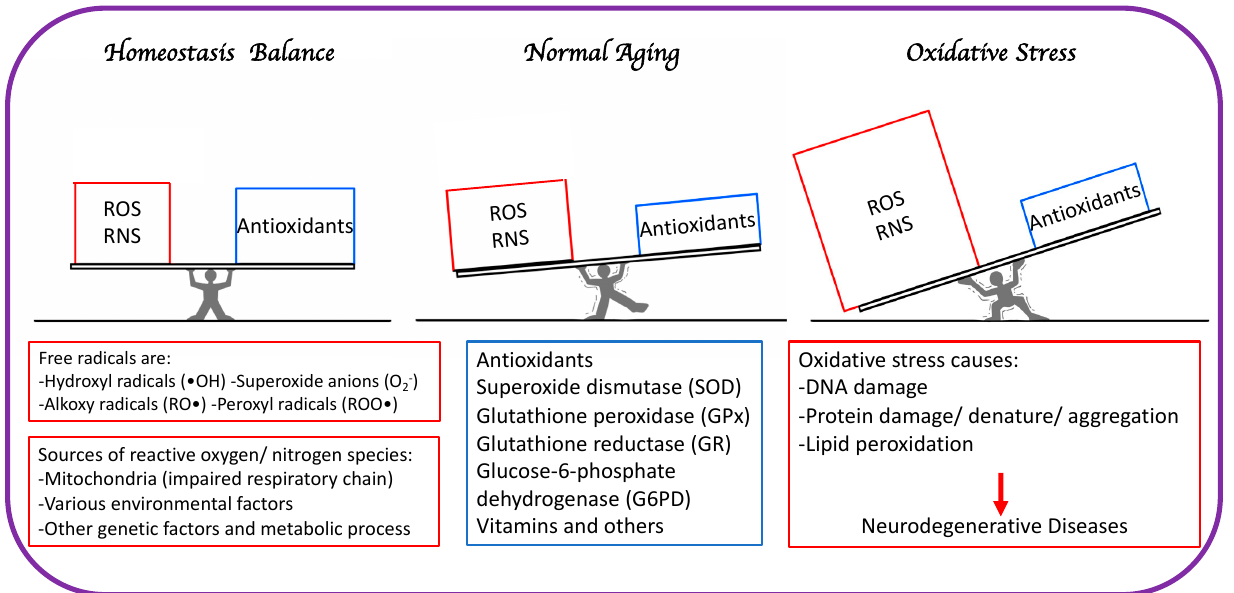
Figure 1. The primary distinction between healthy aging and accelerated aging is the balance between free radical generation (RNS and ROS) and antioxidation to minimize oxidative stress.